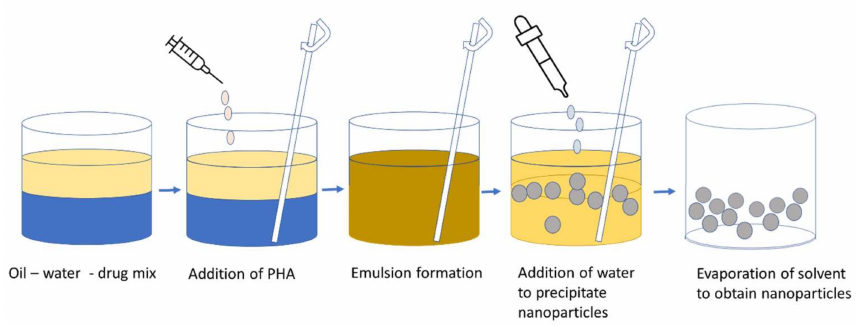
Figure 6. Emulsion Solvent Diffusion (Inspired from Kumar and Lal,